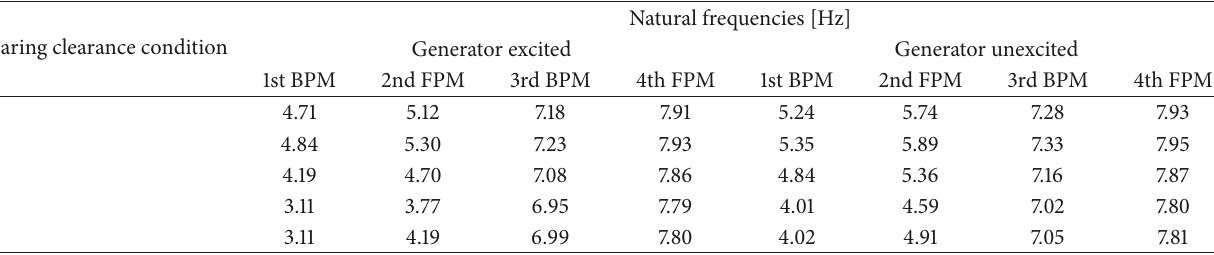
Table 7: Natural frequencies of 1st Backward Precession Mode (BPM), 2nd Forward Precession Mode (FPM), 3rd BPM, and 4th FPM, with generator excited and unexcited.